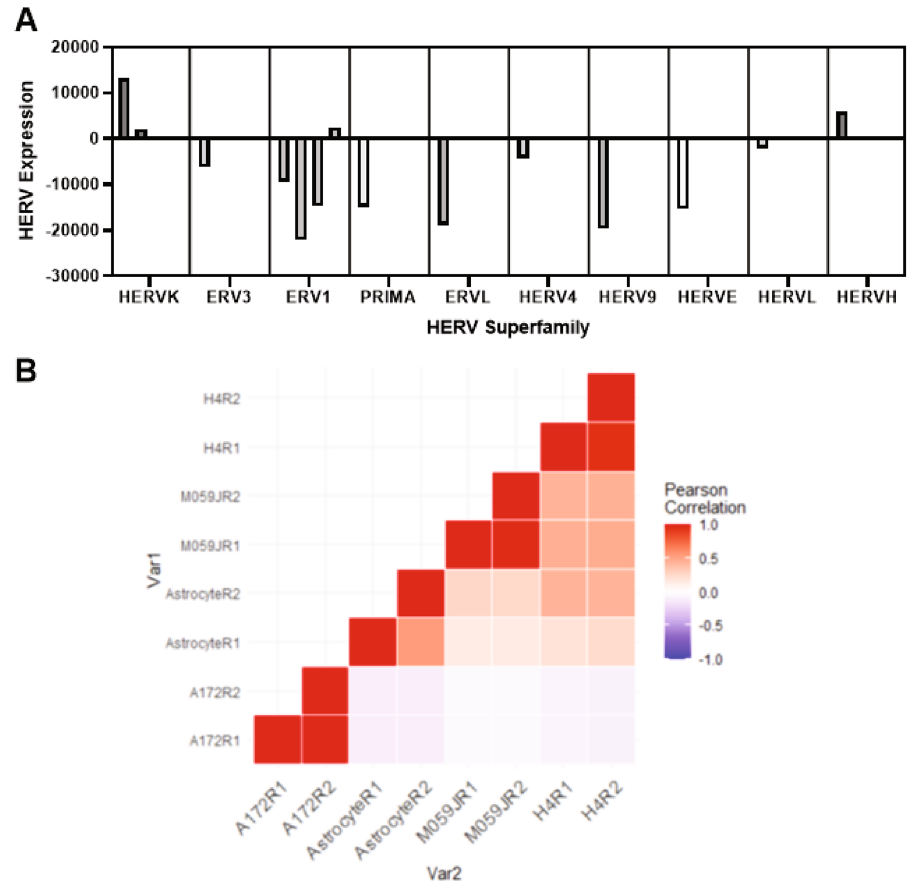
Figure 1. Among all investigated HERVs, certain HERV superfamilies demonstrated high degrees of dysregulation in the A172, M059J, and H4 cell lines in ( A ). ( B ) demonstrates the relative expression of highly dysregulated loci in each cell line and correlates HERV expression in each cell line Namely, A172 cell lines, which demonstrate the highest overall HERV expression, are most significantly correlated with each other, but have almost no association with other investigated cell